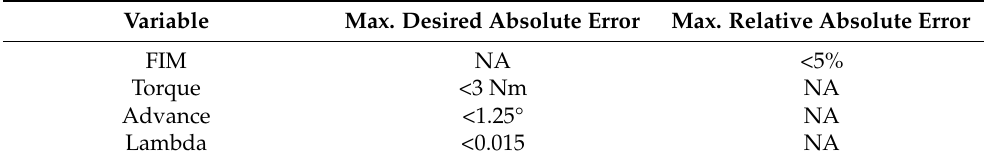
Table 4. Model validation